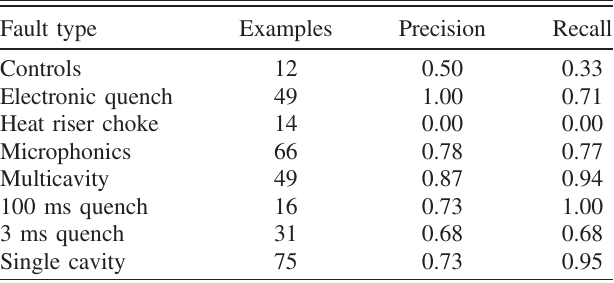
TABLE VII. Precision and recall table for the deployed fault identification model on 312 fault events from March 10 – 24, 2020. Note that during this time the model did not predict any heat riser choke faults, which is why the precision and recall are both